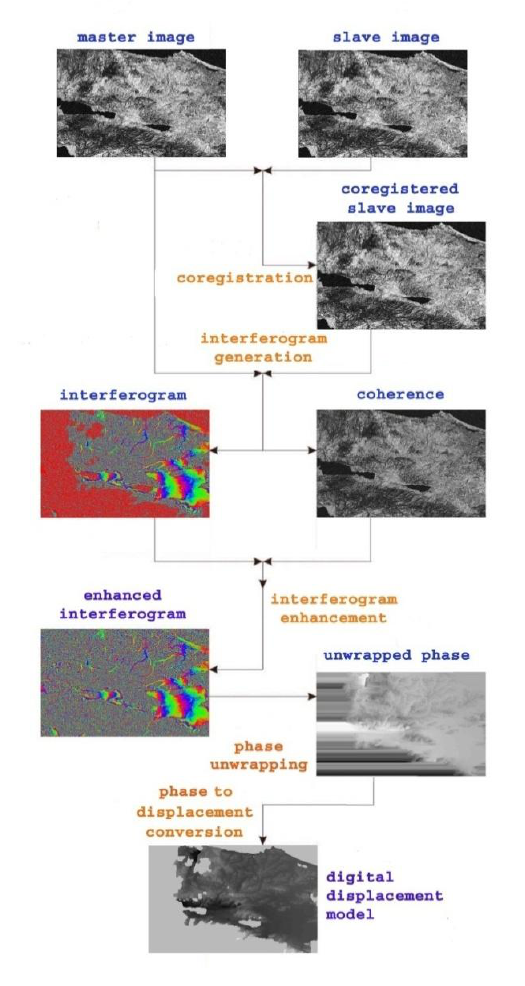
Figure 1: DInSAR Method flowchart (image source: Author) In single-pass InSAR, space-craft has two SAR instrument aboard which acquire data for the same area from different view angles at the same time. With single-pass, the third dimension can be extracted and the phase difference between the first and second radar imaging instruments give the height value of the point of interest using mathematical method. (Henderson, et al. 1998) SRTM (Shuttle Radar Topography Mission) used the single-pass interferometry technique in C- and X-band. Earth’s height model generated by InSAR-SRTM with 90-m horizontal resolution is available while the DEM with 4-to-4.5-m relative accuracy is also available for restricted areas around the globe. (Tarikhi, 2009) When using InSAR technique the resulted interferogram expresses surface deformation in the form of color changes which represents the whole range of the phase from 0 to 2  in a full color cycle. The slight deformation of the surface causes the change of color accordingly; therefore, the steep deformation of the surface corresponds to the steep change of color. In an interferogram moving from red to violet in the pattern indicates that the surface